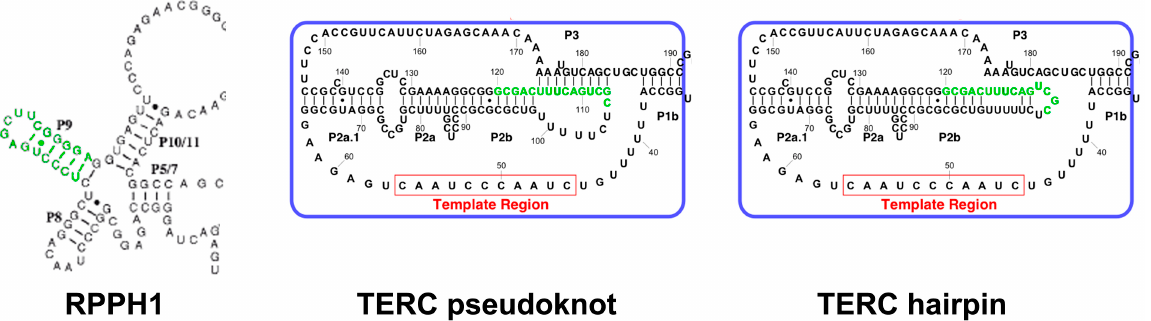
Figure 5. RNA structure and mitochondrial import. RPPH1 (RNA component of RNAse P, left ) shows a stem-loop (in green) that has been experimentally proved to be necessary for mitochondrial import by PNPASE [176]. Cheng et al. [180] () found a similar sequence in TERC (in green) and considered it to have the same structure and role. The latter, however, is not a stem-loop, but is part of the pseudoknot, in the canonical conformation of TERC ( center ). In the alternative, temporary conformation of TERC ( right ) proposed by Denesyuk and Thirumalai [181], the sequence is part of a hairpin.